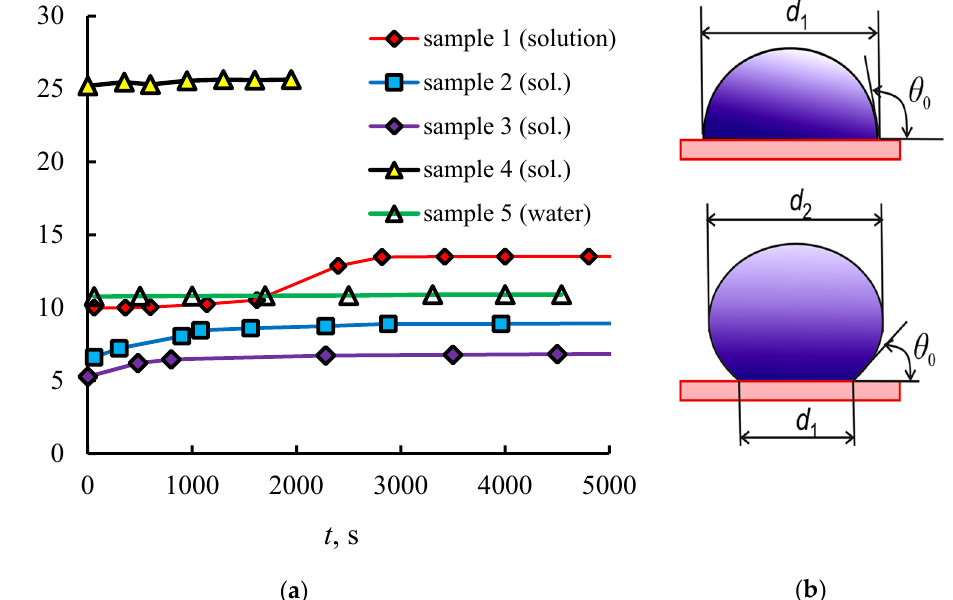
( a ) ( b ) Figure 7. ( a ) The wetted droplet diameter D w with time t ( T w = 41 °C, samples correspond to Table Figure 7. ( a ) The wetted droplet diameter D w with time t ( T w = 41 ◦ C, samples correspond to Table 1). 1). ( b ) The droplet diameters for different droplet shapes ( d 1 = D w ). ( b ) The droplet diameters for different droplet shapes ( d 1 = D w